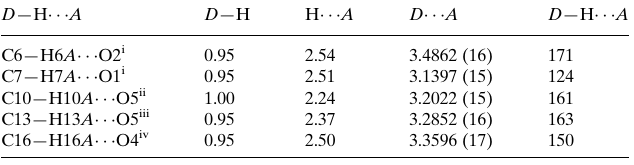
Hydrogen-bond geometry (A˚ , (cid:2)